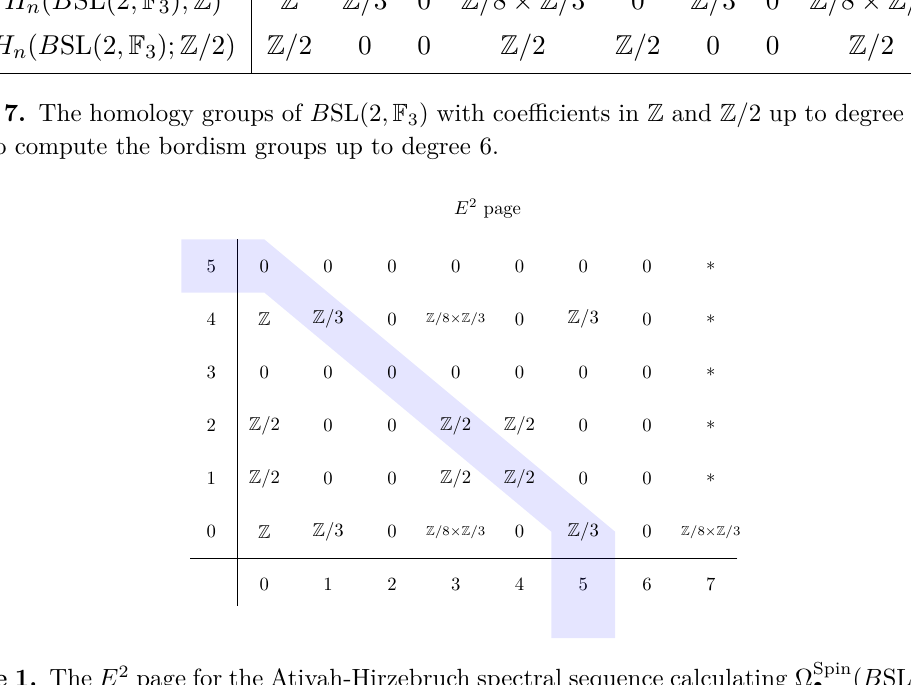
Figure 1. The E 2 page for the Atiyah-Hirzebruch spectral sequence calculating Ω Spin • ( B SL(2 , F 3 ))